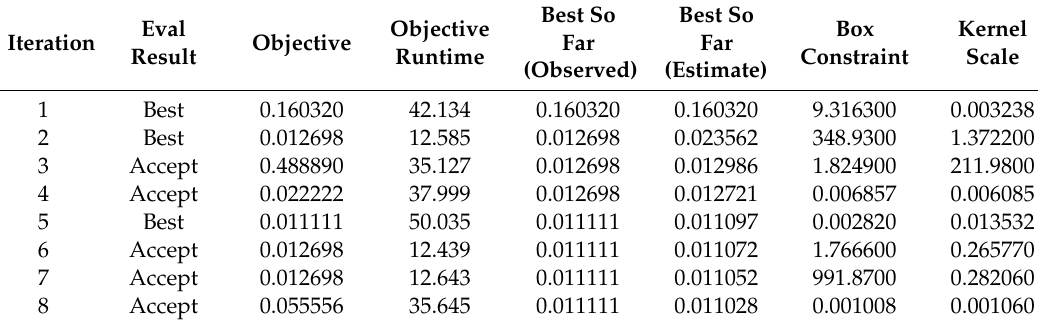
Table 2. ASVM vector machine to find the optimal kernel.